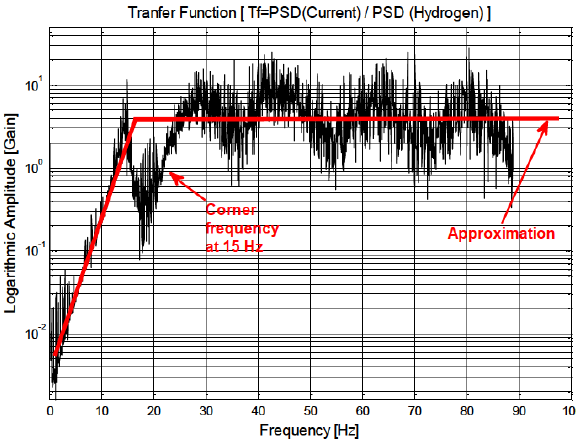
Figure 10: Magnitude variation of the fuel cell transfer